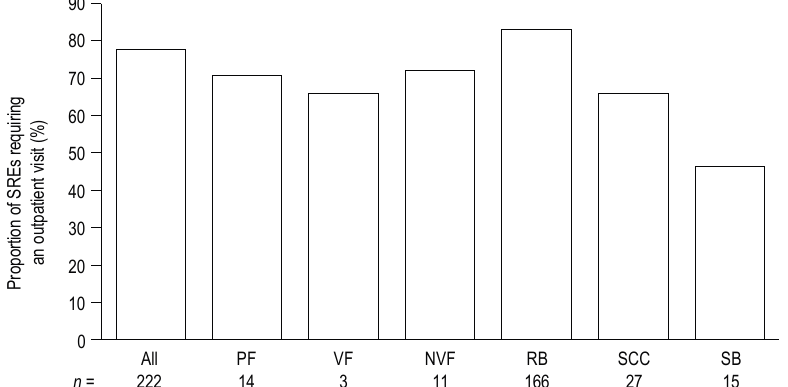
Figure 4. Proportion of SREs requiring an outpatient visit. Data show the proportion of SREs requiring an outpatient visit. Data for PF are shown first overall, and then by VF and NVF subcategories.